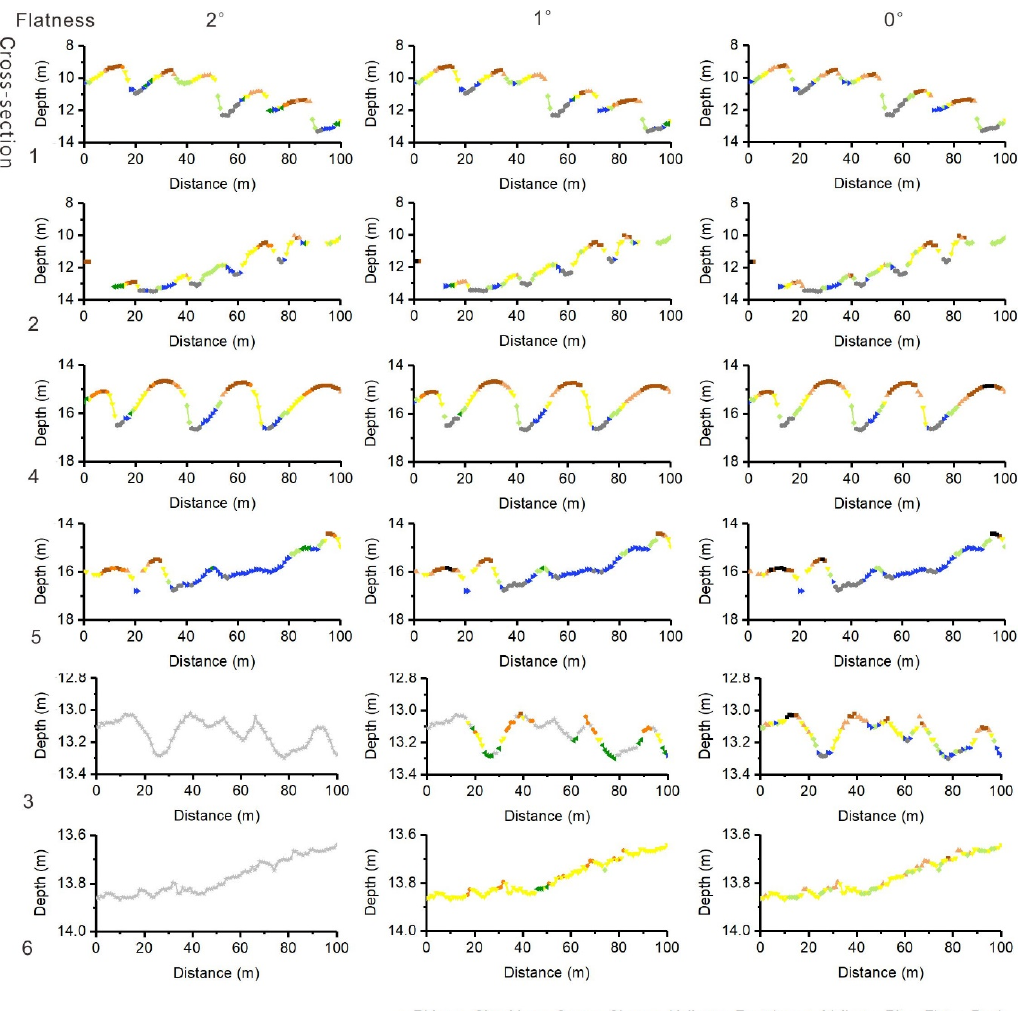
Figure 8. Water depth profile overlaid by geomorphons-based elements for Cross-sections 1–6 under various flatness degrees.